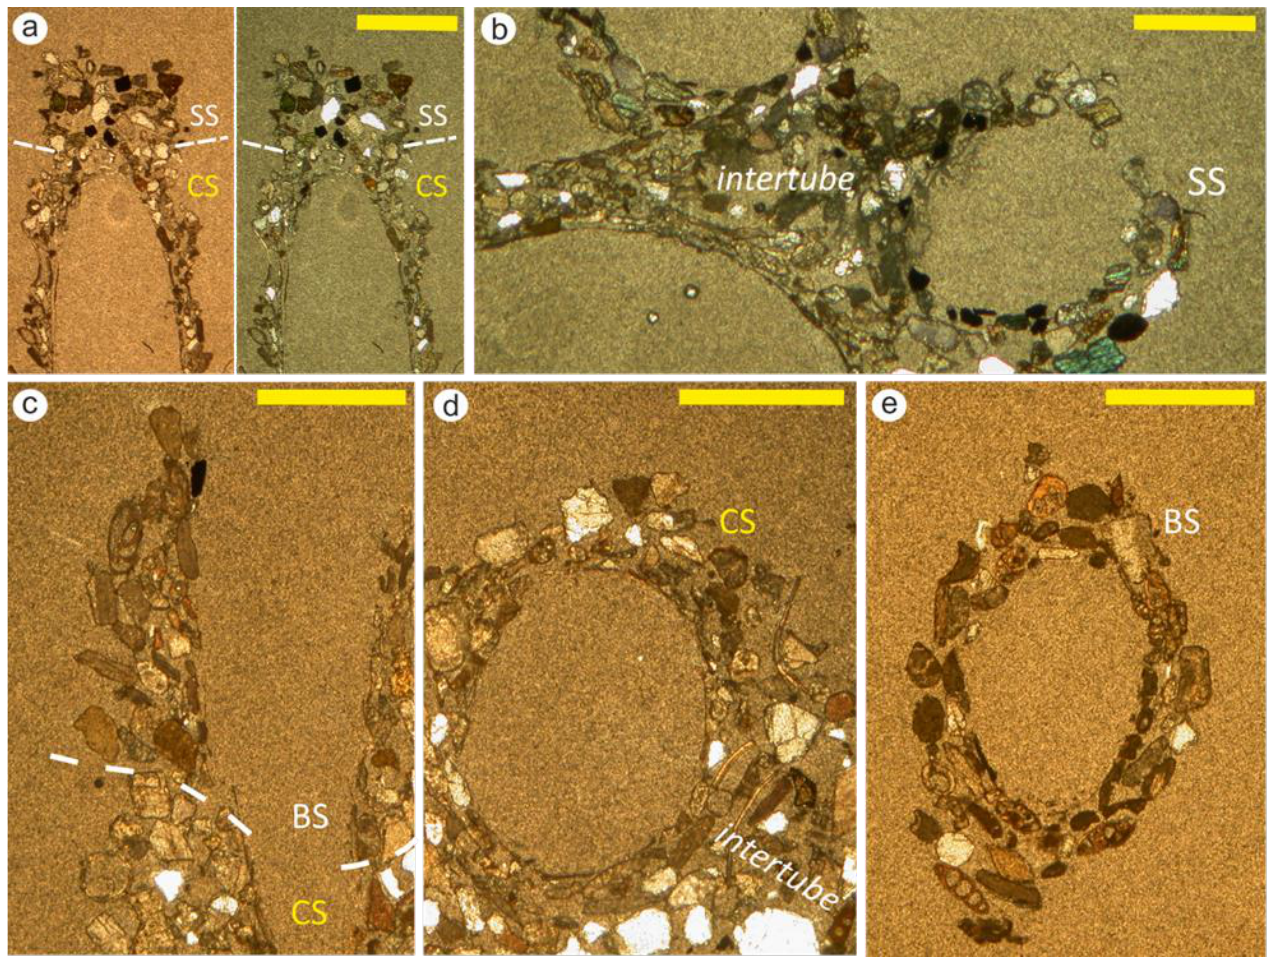
Figure 8. Details of the tube growth in the test tanks during phase I, in thin section. ( a ) Test tank 2. Thin section cut parallel to the tube growth (plane-polarized light and crossed-polarized photos). A white dotted line separates the natural tube from the sector growths during the test. In the tank, the worm captured the siliciclastic sands (SS) of Margherita di Savoia, building its tube in continuity with the natural tube sampled in the reef of Torre Mileto (calcilithic sand (CS)). Note the abundance of magnetite (always black in plane-polarized light and crossed-polarized photos) and pyroxene minerals in the upper part of the tube, grown in the laboratory. ( b ) Test tank 2. Thin section cut perpendicular to the tube growth (crossed-polarized photo). The circular structure of the tube was formed only by siliciclastic minerals. The most elongated grains were arranged tangentially to the circular vacuum occupied by the worm. The area between adjacent tubes (intertube) was filled by sand not directly selected by the worm. ( c ) Test tank 3. Thin section cut parallel to the tube growth (plane-polarized light photo). A white dotted line separates the natural tube sand (CS) from the bioclastic sand (Porto Cesareo BS) captured by the worm during the test. Note the presence of lithoclasts and quartz only in the basal/natural part of the tube (CS). ( d , e ) Test tank 3. Thin sections cut perpendicular to the tube growth (plane-polarized light photo) of both the basal/natural part of the tube (CS; d ) and the upper sector of the tubes grown in the laboratory (BS; e ). Note that the structure of the tube (geometry and thickness) and the grain size/arrangement of the sands are very similar. In ( d ) is also visible the intertube area in conditions of natural growth, which is similar to the intertube area shown in ( b ) (for tubes grown in the laboratory). The yellow scale bar indicates 500 µ m. Thin sections cut parallel to the growth of tubes (Figure 8a,c) indicated that what was observed and measured on macroscopic samples could be also confirmed at